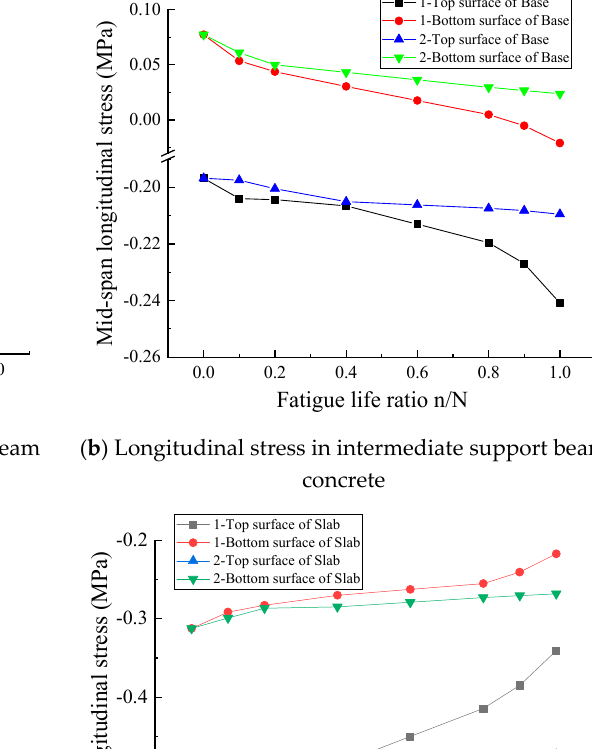
denotes the longitudinal stress considering CA mortar layer degradation.